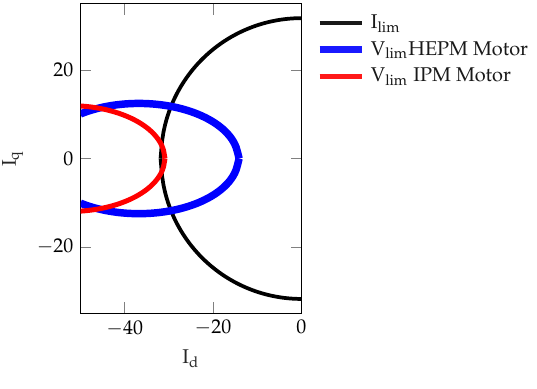
Figure 10. Voltage and current limits of HEPM and IPM at 4350